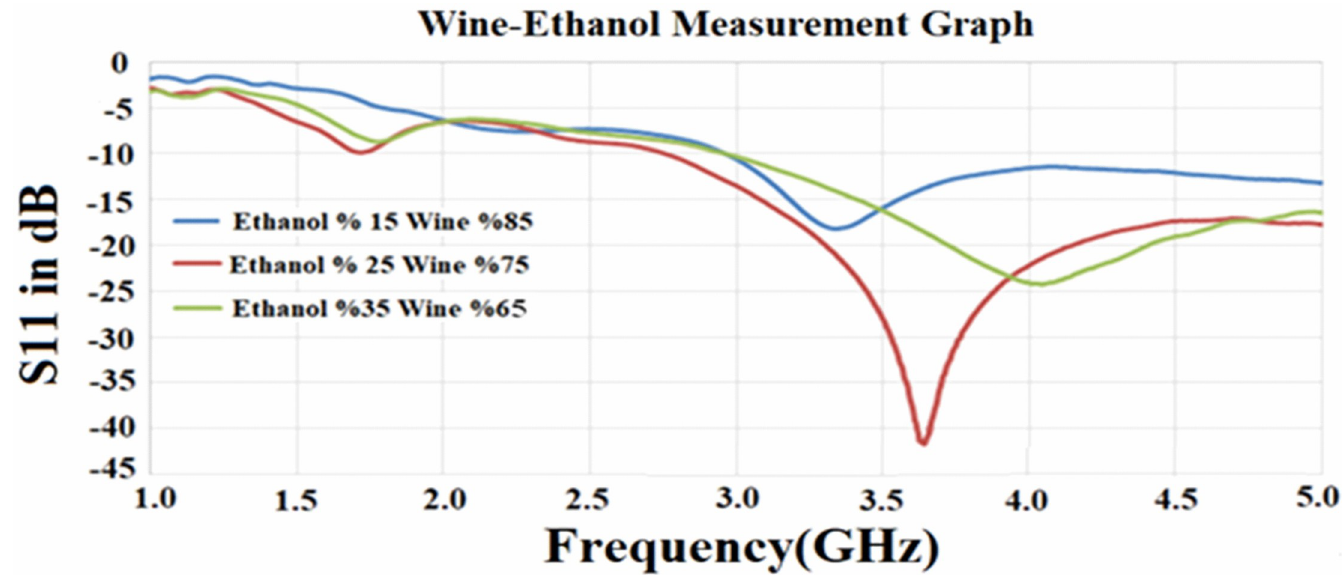
Fig 11. Measured results for PCB rectangular patch antenna with wine-ethanol content.